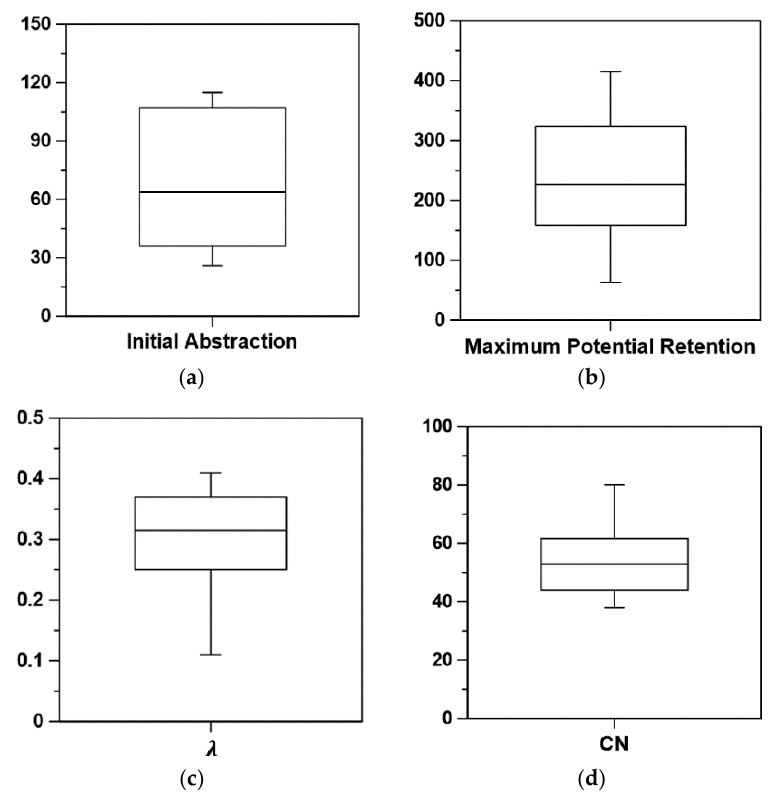
Figure 7. Box-plots of ( a ) initial abstraction, ( b ) maximum potential retention, ( c ) λ , and ( d ) Figure 7. Box ‐ plots of ( a ) initial abstraction, ( b ) maximum potential retention, ( c ) 𝜆 , and ( d ) CN Table 4. Quartiles of initial abstraction, maximum potential retention, and CN. Initial Abstraction